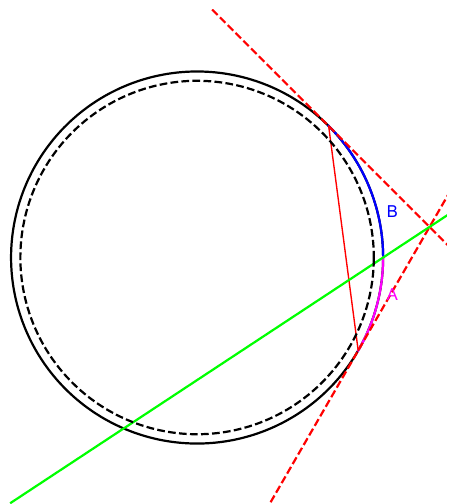
p ( A : B ) is in green. The